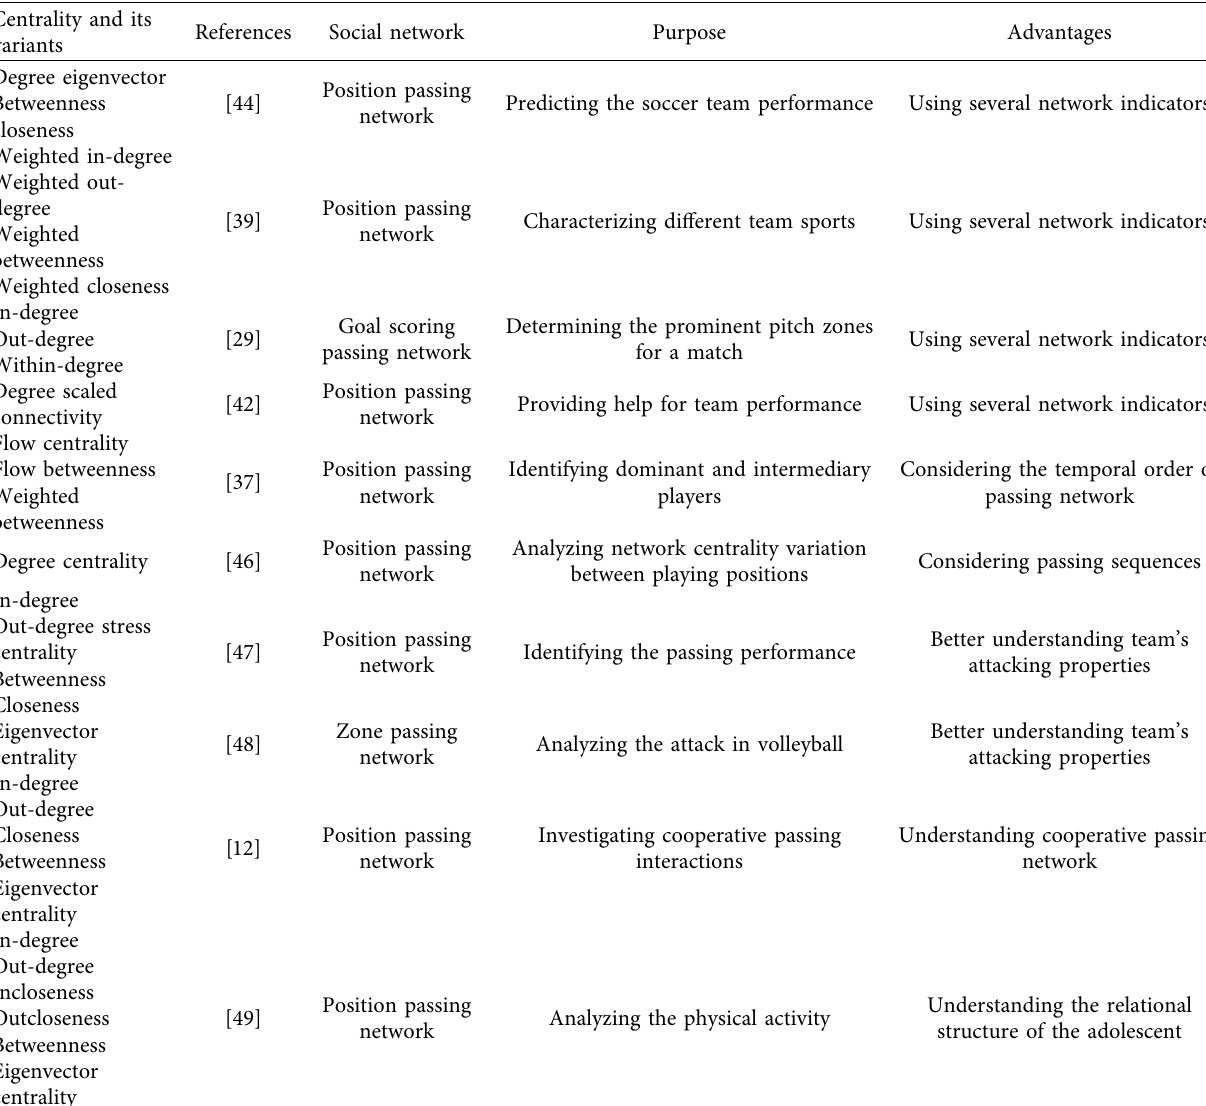
Table 2: Centrality and its variants for sports social network analysis from 2018 to